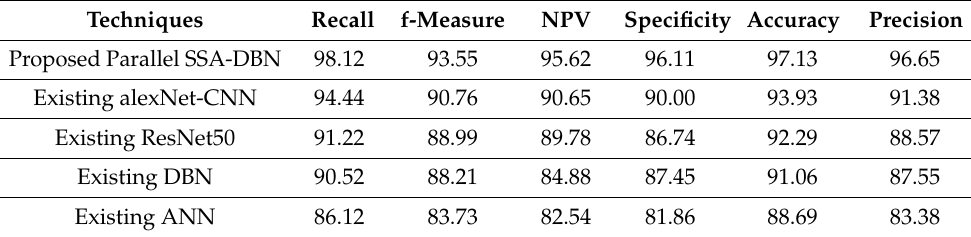
Table 1. Evaluation of classification metrics for the proposed parallel SSA-DBN on recall, f-measure, NPV, specificity, accuracy and